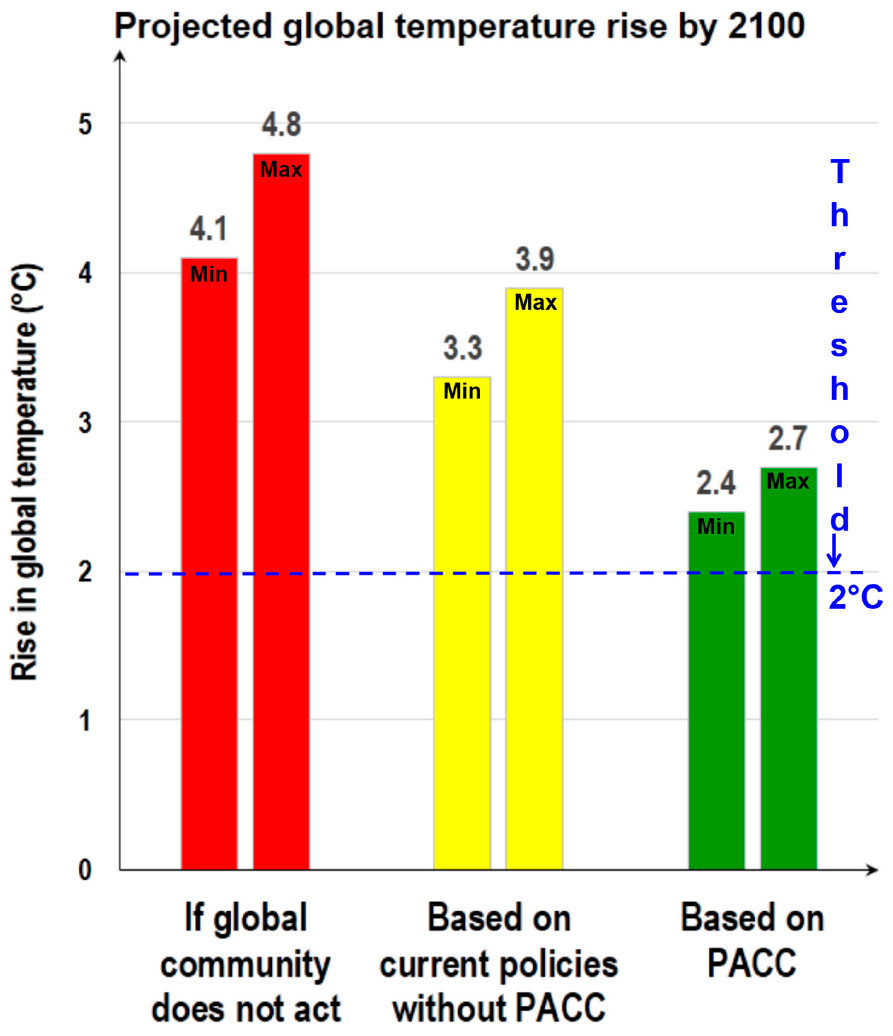
Figure 1. Projected global temperature rise by 2100 and the effect of current policies and the Paris Agreement on Climate Change (PACC). Min: minimum; Max: maximum. This figure is prepared based on the data published by Climate Action Tracker [9].